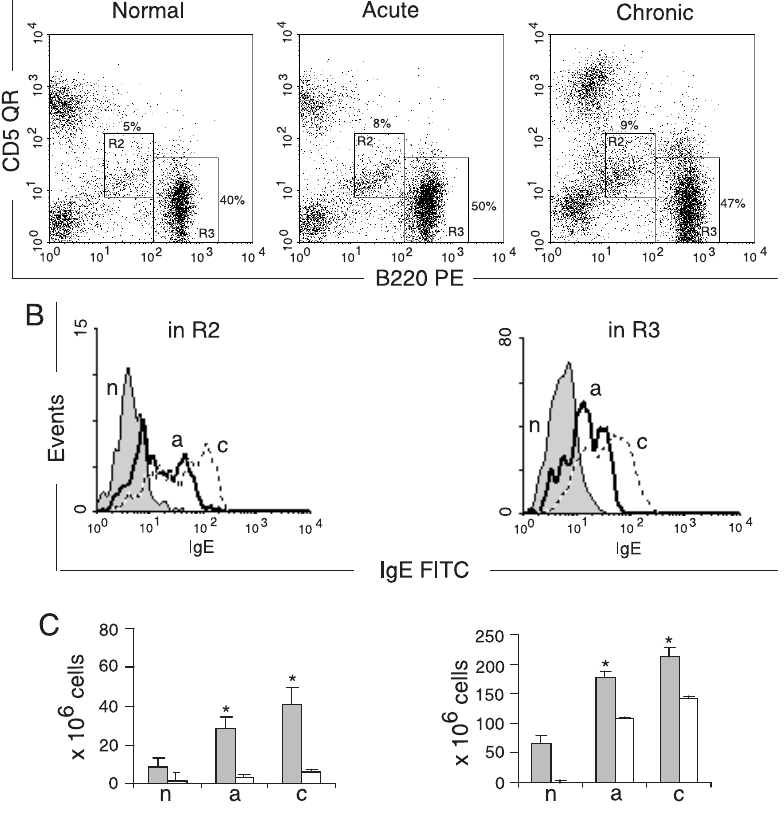
Figure 3 . Surface expression of B220, CD5 and IgE on cells from spleen. A , Dot plot of cells in the lymphocyte gate. The R2 and R3 regions represent the B1 and B2 cells, respectively. B , Intensity of IgE on the B-cell surface. C , Total cell numbers (filled col- umns) and IgE+ cells (open col- umns). Data are reported as means ± SEM and are represen- tative of five independent experi- ments, each carried out in 2 nor- mal mice (n), 5 mice with acute infection (a) and 5 with chronic infection (c). *P < 0.05 for B-IgE + cells compared to total B cells (Tukey multiple comparison